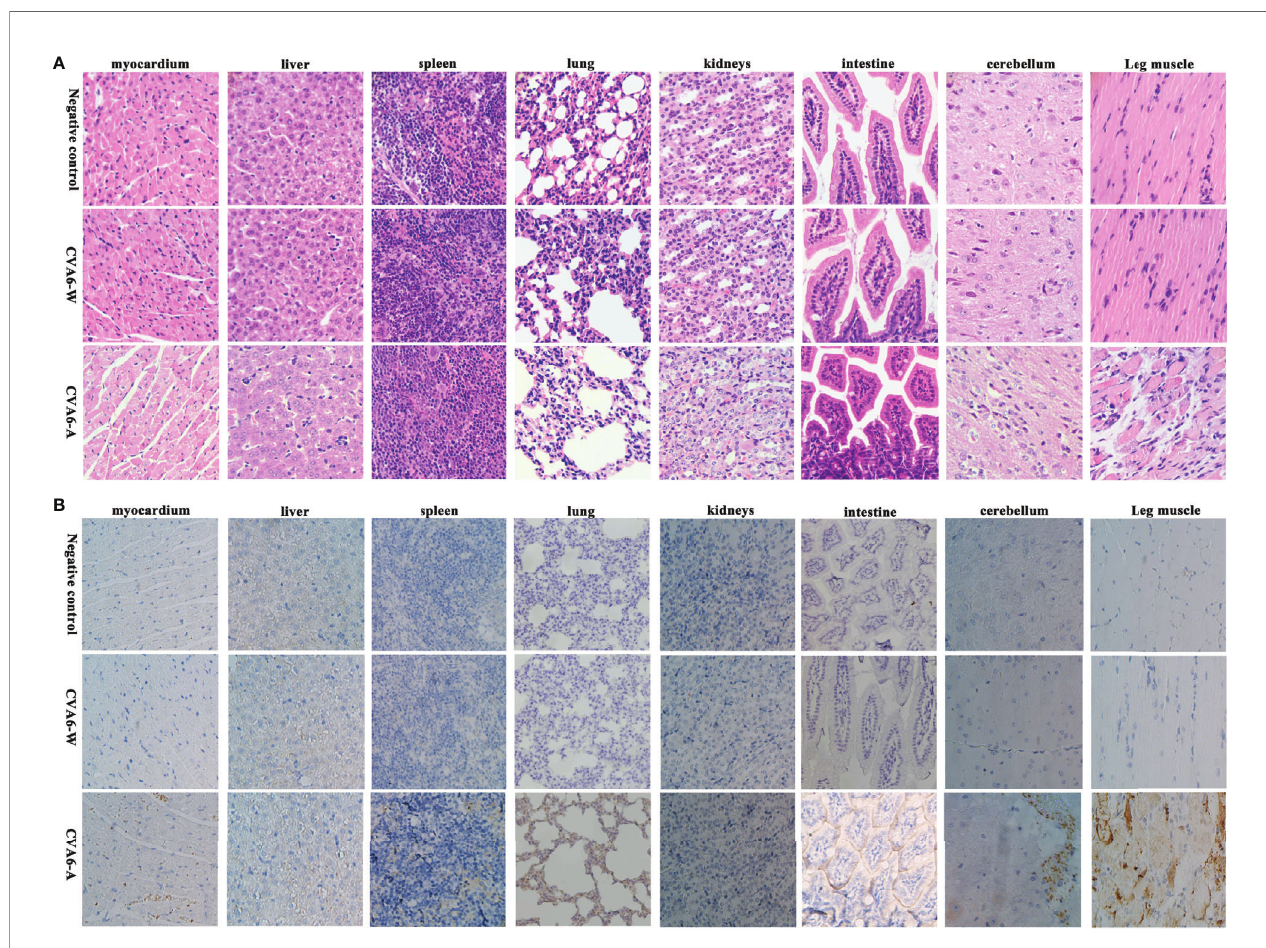
FIGURE 3 | The analysis of the histopathological and immunohistochemical (IHC) examination (200×). Ten-day-old suckling mice were intraperitoneally injected with a lethal dose of coxsackievirus A6 (CVA6)-A, a similar viral load of CVA6-W, as well as an identical volume of DMEM (NC group). The myocardium, liver, spleen, lung, kidneys, intestine, cerebrum, and leg muscle tissues were made into pathological sections and observed (A) . IHC examination was performed using anti-CVA6 VP2 antibody (B) .